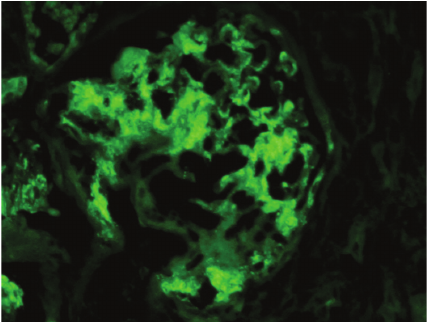
Figure 4: Medium-power view showing a glomerulus with di ff use granular mesangial positivity of IgM on IF study. (IgM, × 200).